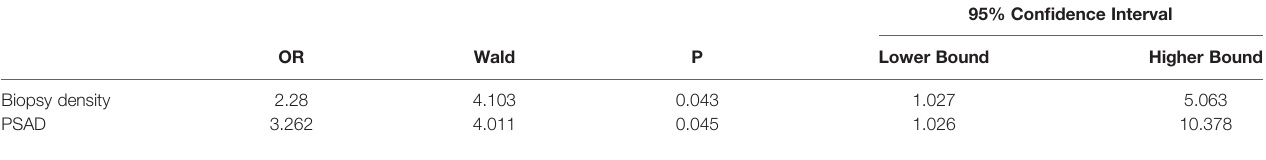
Lower Bound Higher Bound